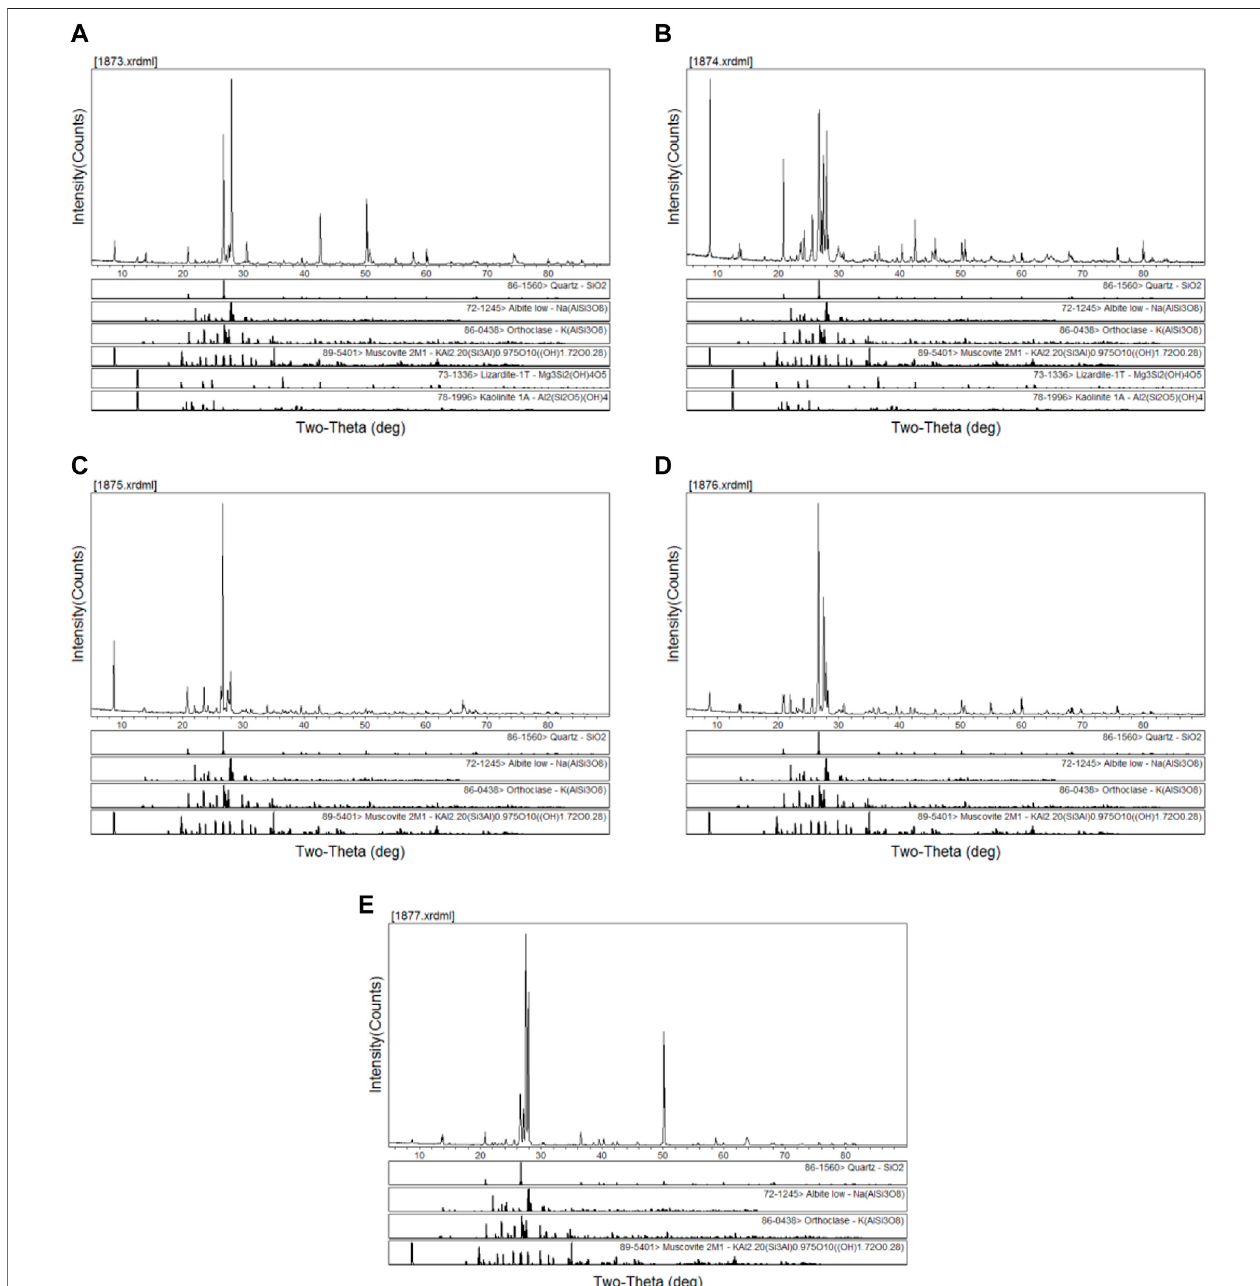
FIGURE 12 | X-ray diffraction phase analysis of granite at different temperatures: (A) 25 ° C, (B) 200 ° C, (C) 400 ° C, (D) 600 ° C, and (E) 800 ° C.